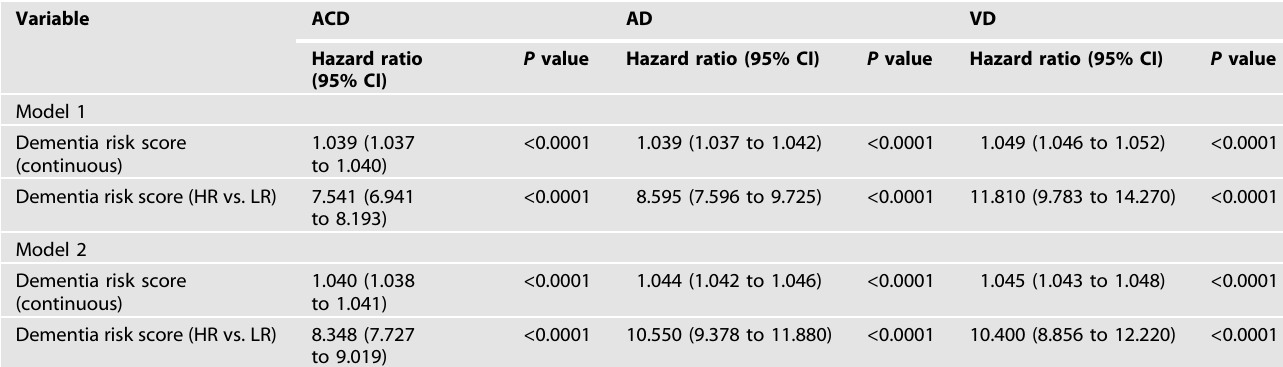
Table 3. Cox regression analysis on the dementia risk score associated with dementia